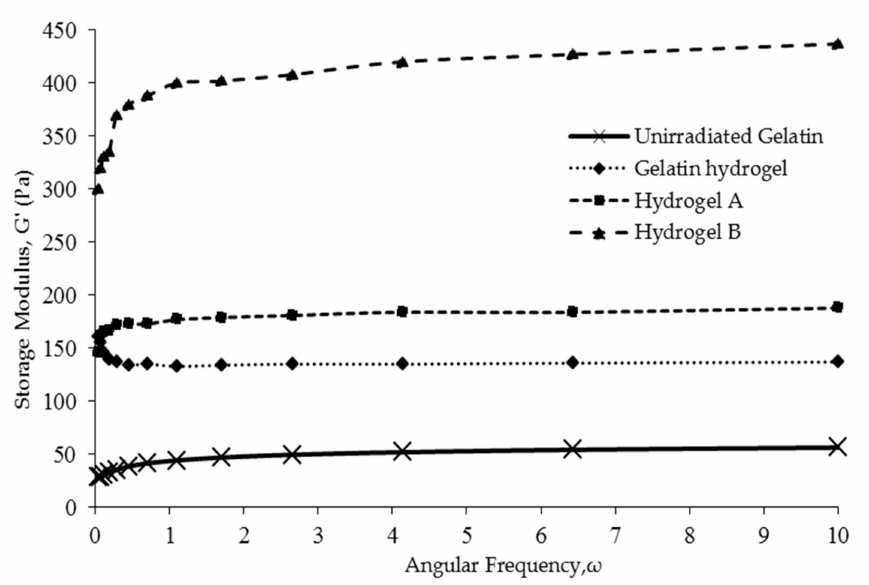
Figure 5. Storage moduli of unirradiated gelatin, gelatin hydrogels, hydrogels A, and hydrogels